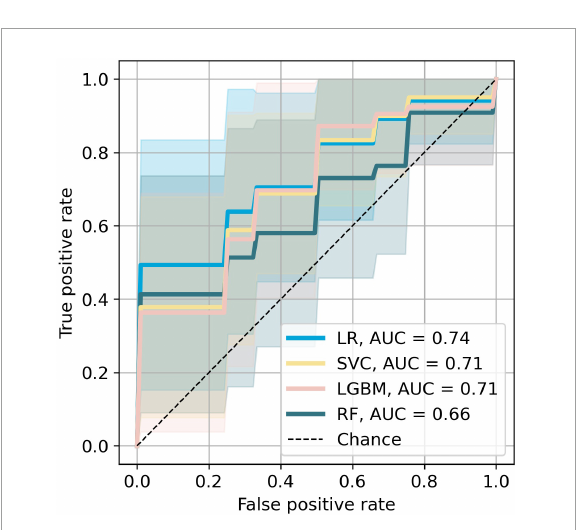
FIGURE4 Receiver operating characteristic curves of the most accurate four models. The colored areas represent the 95% CI.